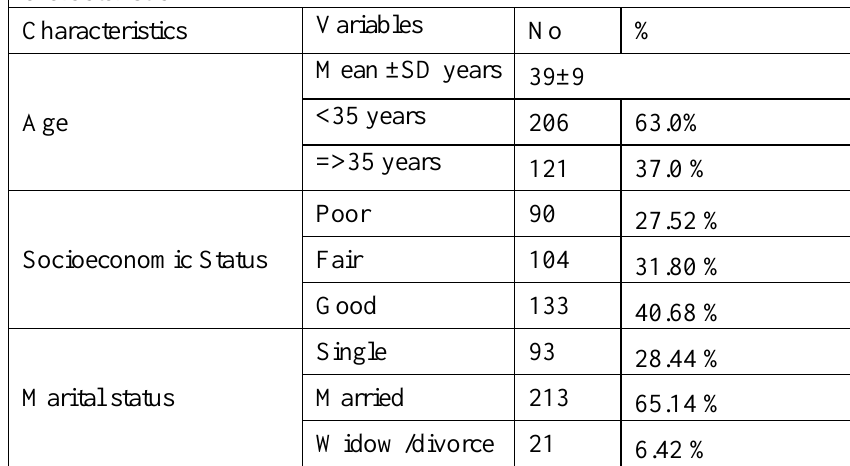
Table 1. The distribution of CTE patients according to sociodemographic characteristic